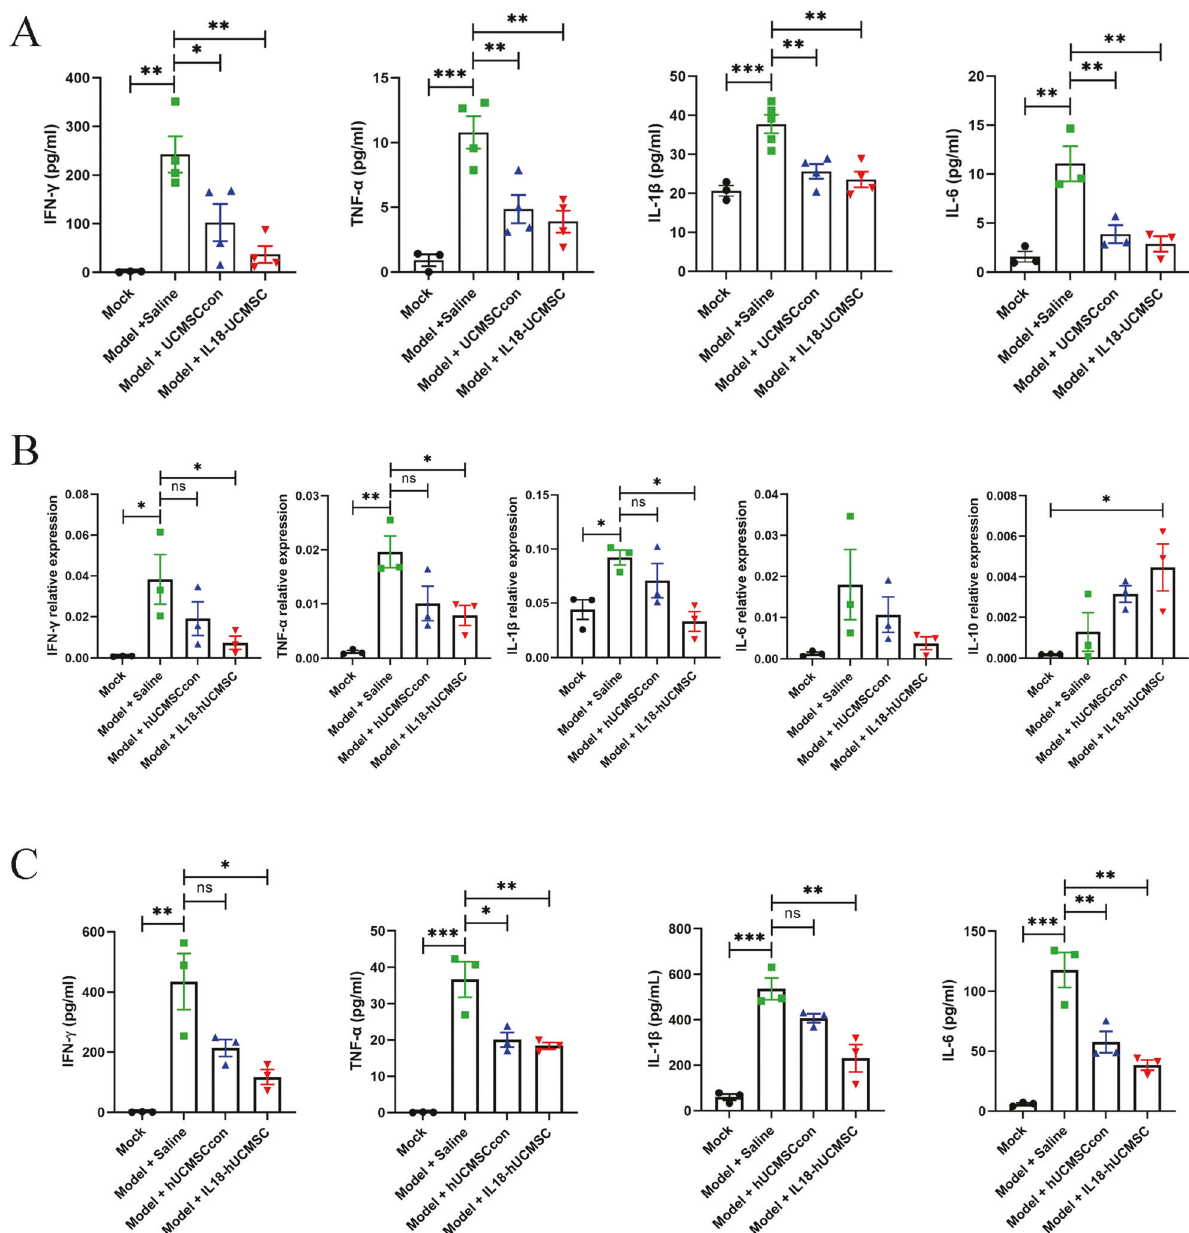
ELISA kit. B The mRNA expression of IFN- γ , TNF- α , IL-1 β , IL-6, and IL-10 in lung tissue was analyzed by qPCR. C The protein level of IFN- γ , TNF- α , IL-1 β , and IL-6 in lung tissues in different groups at 7 dpi was analyzed by ELISA kit. Data are shown as mean ± SEM. n = 3 – 5 in each group. * p < 0.05, ** p < 0.01, *** p < 0.001, ns = not signi fi